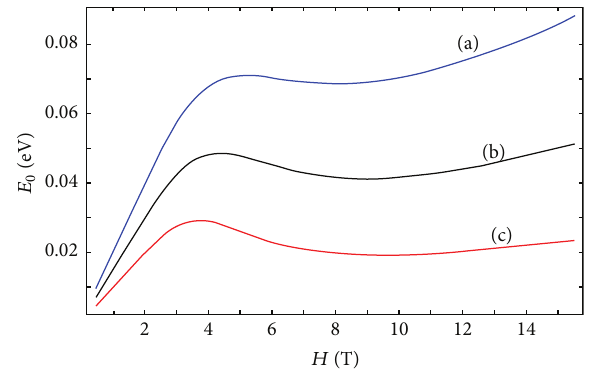
Figure 2: Binding energy 𝐸 0 versus the magnetic field intensity 𝐻 . = 2 ℏ𝑢 𝑔 = 1 . 5 ℏ𝑢 (a) 𝑔 𝐹 , (b) 𝐹 , and (c) el-el el-el